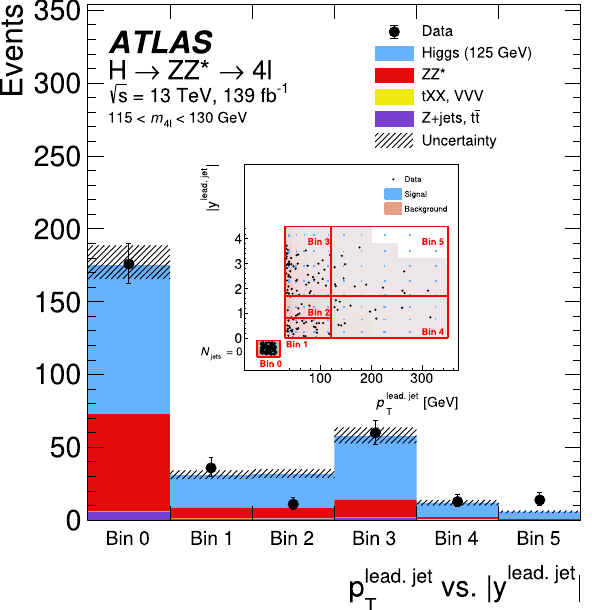
Fig. 16 The observed and expected (pre-fit) distribution in bins of the Fig. 17 The observed and expected (pre-fit) distribution in bins of the . jet transverse momentum of the leading vs. subleading jet, p lead vs. transverse momentum vs. the rapidity of the leading jet, p lead T . jet | y lead . jet | . The same distribution in the 2D plane is provided in the inset p sublead . The same distribution in the 2D plane is provided in the T plot, where the black dots depict data and the blue and pink shaded inset plot, where the black dots depict data and the blue and pink shaded areas represent simulated signal and background, respectively. The red areas represent simulated signal and background, respectively. The red lines depict the bin boundaries, chosen as described in Sect. 7. These lines depict the bin boundaries, chosen as described in Sect. 7. These distributions correspond to the mass region 115 < m 4 (cid:3) < 130 GeV distributions correspond to the mass region 115 < m 4 (cid:3) < 130 GeV √ for an integrated luminosity of 139 fb − 1 collected at for an integrated luminosity of 139 fb − 1 collected at s = 13 TeV. A SM Higgs boson signal with a mass m H = 125 GeV is assumed. A SM Higgs boson signal with a mass m H = 125 GeV is assumed. The uncertainty in the prediction is shown by the hatched band, which The uncertainty in the prediction is shown by the hatched band, which includes the theoretical uncertainties of the SM cross section for the includes the theoretical uncertainties of the SM cross section for the . jet . jet signal and the Z Z ∗ signal and the Z Z ∗ background. p lead and p sublead are required T T to have p T greater than 30 GeV